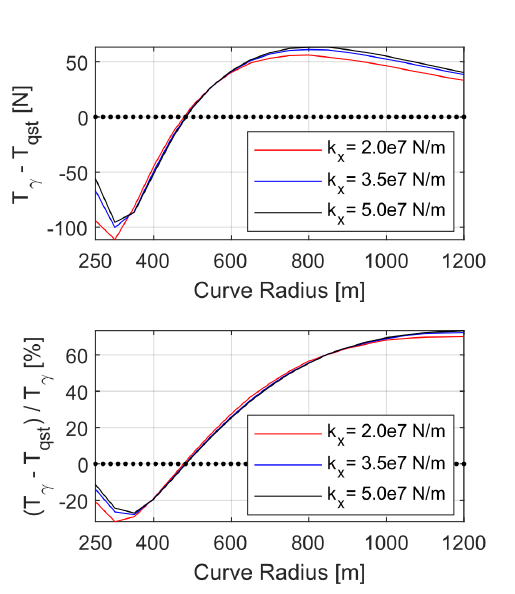
Figure 15. The difference T γ − T qst depending on the curve radius R (above) and the relative difference ( T γ − T qst ) /T γ depending on the curve radius R (be- low) in the defined range of the longitudinal stiffness of wheelset guiding k x per one